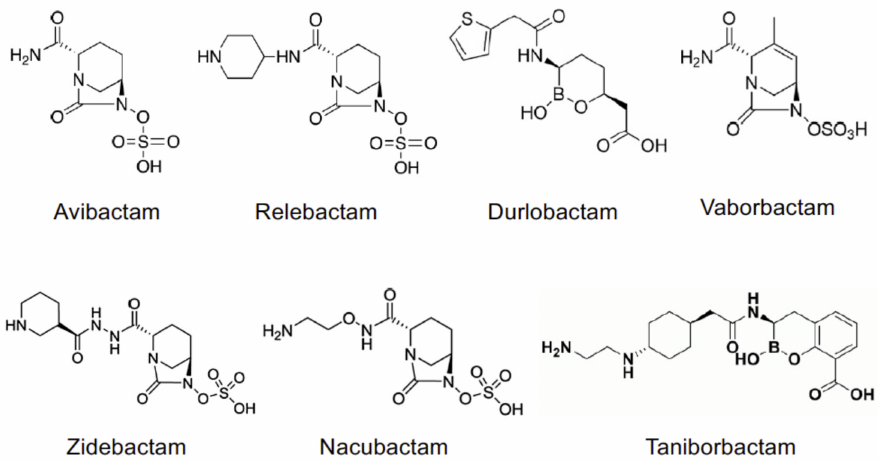
Figure 1. Chemical structures of non-beta-lactam